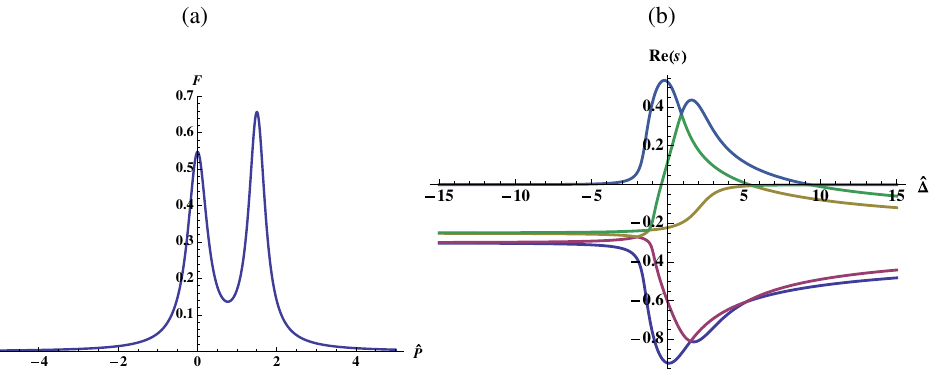
¼ 0 : 3 , (cid:9) ¼ 0 : 25 , (cid:8) ¼ 1 : 5 . (b) Real parts of five roots of the 1 2